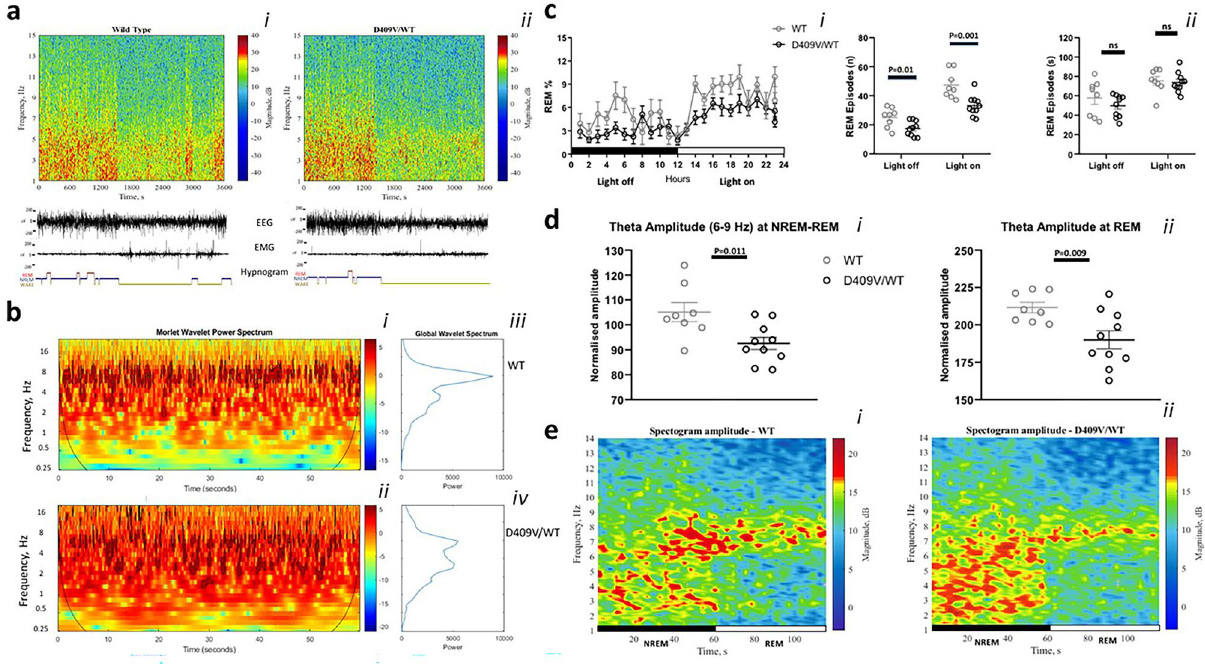
Figure 1. Specificity of Rapid Eye Movement (REM) sleep in D409V/WT. In ( a ), the representative EEG power, EEG/EMG traces, and hypnograms over one hour period are shown. Examples of amplitude spectograms ( right , scale bar; dB), EEG/EMG traces, and hypnograms over one hour period at “light-on” are shown from a representative WT and D409V/WT-mouse. In ( b ), Morlet-and-Global-Wavelet-Spectrums of REM sleep in WT and D409V/WT-mice are depicted. Morlet spectrums ( right , scale-bar; log10 relative power) were generated by averaging all REM-periods lasting one minute at “lights-on”-period; shown as a function of frequency and time (b i, bii ). A significantly reduced power at the theta-frequency-range and an intrusion of a lower-frequency- range (1–4 Hz, delta) in D409V/WT is shown(b i, bii ). Global-wavelet-spectrums similarly depict changes (b iii, biv ). In ( c ), a significant reduction in REM in D409V/WT, by comparison to WT, during 24-h-EEG-recordings are shown (c i ; P = .035). The decrease was due to a reduction in the number ( P = .001 and P = .01; c ii ) and not duration of REM episodes (c iii ). In ( d ), significant reductions in theta range are shown at both NREM-to-REM- transitions (60 s; P = .011; d i ) and during the subsequent REM (60–120 s; P = .009; d ii ). In ( e ), similar changes by comparison to WT are depicted via representative spectograms of EEG-data-power (dB); shown as a function of frequency and time (e i , e ii